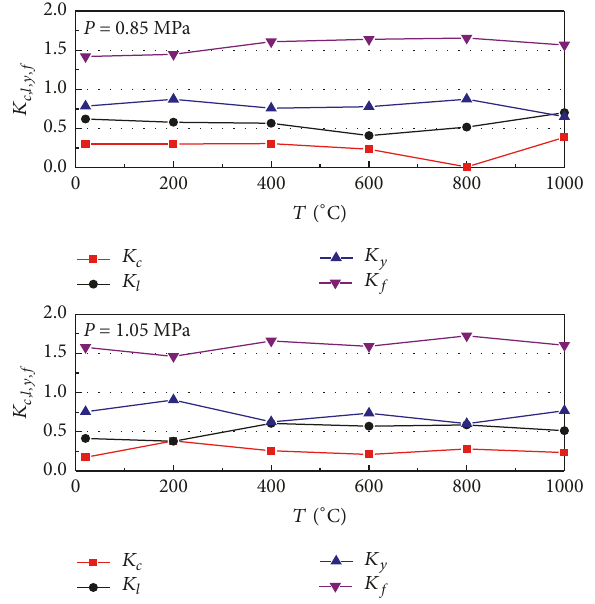
Figure 12: 𝐾 𝑐,𝑙,𝑦,𝑓 of sandstone specimens after high temperature